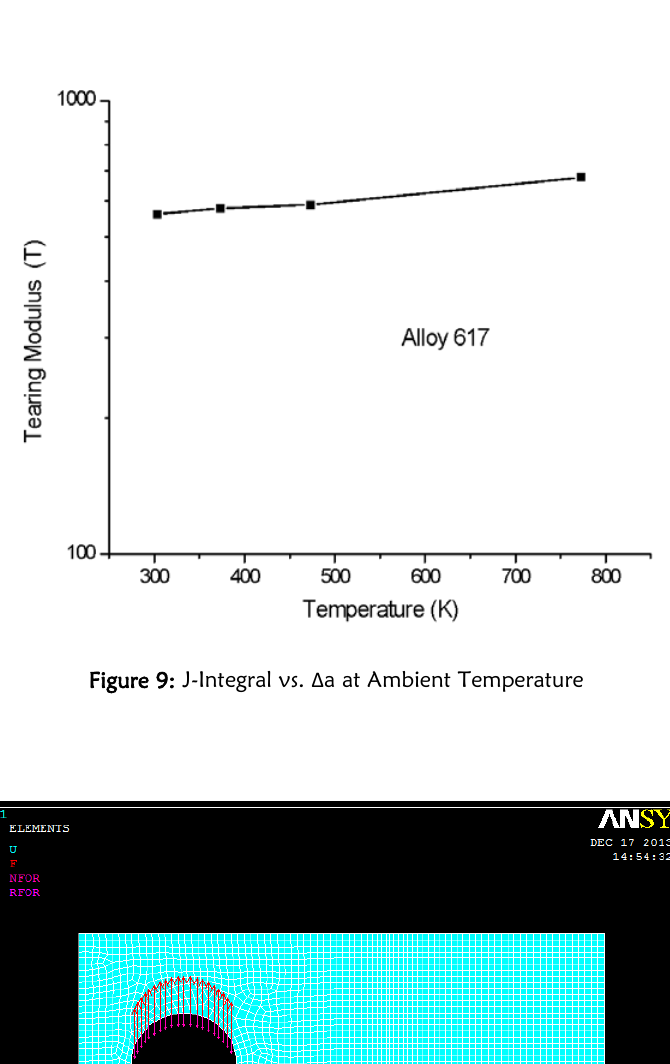
plasticity [21]. This is shown in Fig.14 where the J values do not converge easily to a single value but show a path dependency at 400 o C. Path independency for J integral was observed even until 500 o C for the alloy 617 but as the temperature reaches 400 o C for alloy 276 the J values show path dependence. Cracking deformation behaviour in nickel-based superalloys with stress and strain characteristics are correlated by finite element analysis of microscopic and macroscopic structures